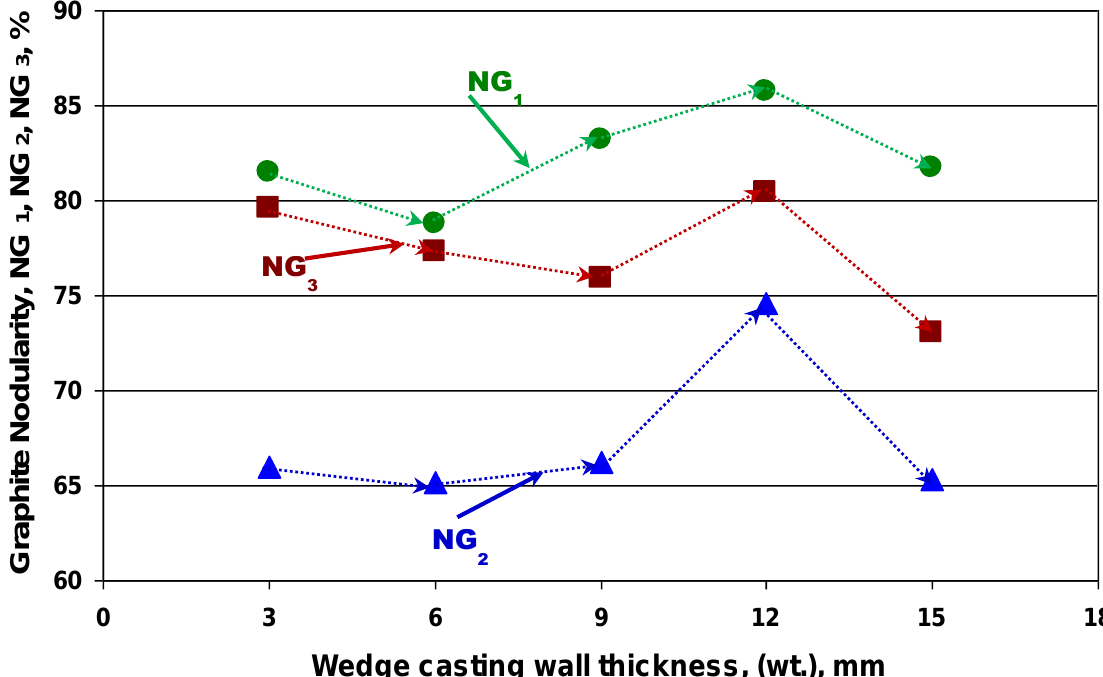
Figure 10. Graphite nodularity calculated using the graphite Roundness Shape Factor (RSF), accord- ing to ISO 16112:2017–CGI (NG 1 ) and ISO 945-4-2019-DI (NG 2 ), and by replacing the RSF with the Graphite Sphericity Shape Factor (SSF) according to ISO 945-4-2019-DI formula (NG 3 ). By using the graphite nodularity NG 2 formula (Figure 3b), while replacing the Round- ness Shape Factor (RSF) with the Sphericity Shape Factor (SSF), the graphite nodularity resulted: NG 3 = [( ∑ A NG(SSF ≥ 0.8) + 0.9 ∑ A NG(SSF=0.6–0.80) )/ ∑ A tot ] · 100 (%). Its evolution with close to NG 1 for thin wall thickness (3–6 mm), close to 9 mm thickness, and at an equidistant position of 12–15 mm wall